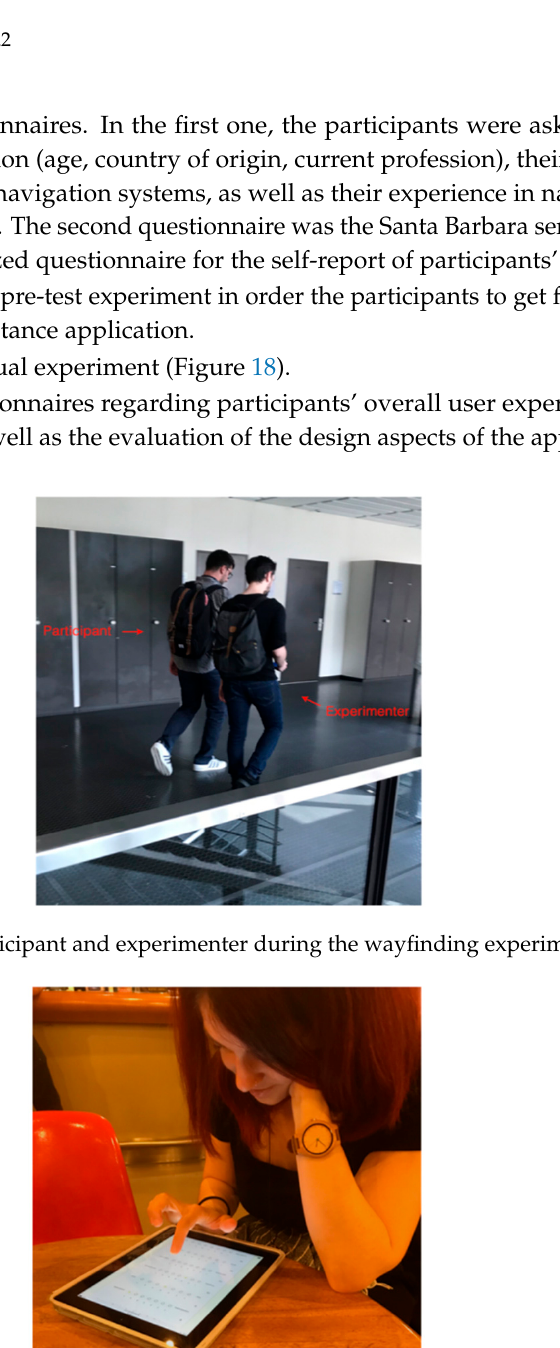
Figure 19. Participant fills in the questionnaire, after finishing experiment’s wayfinding task.